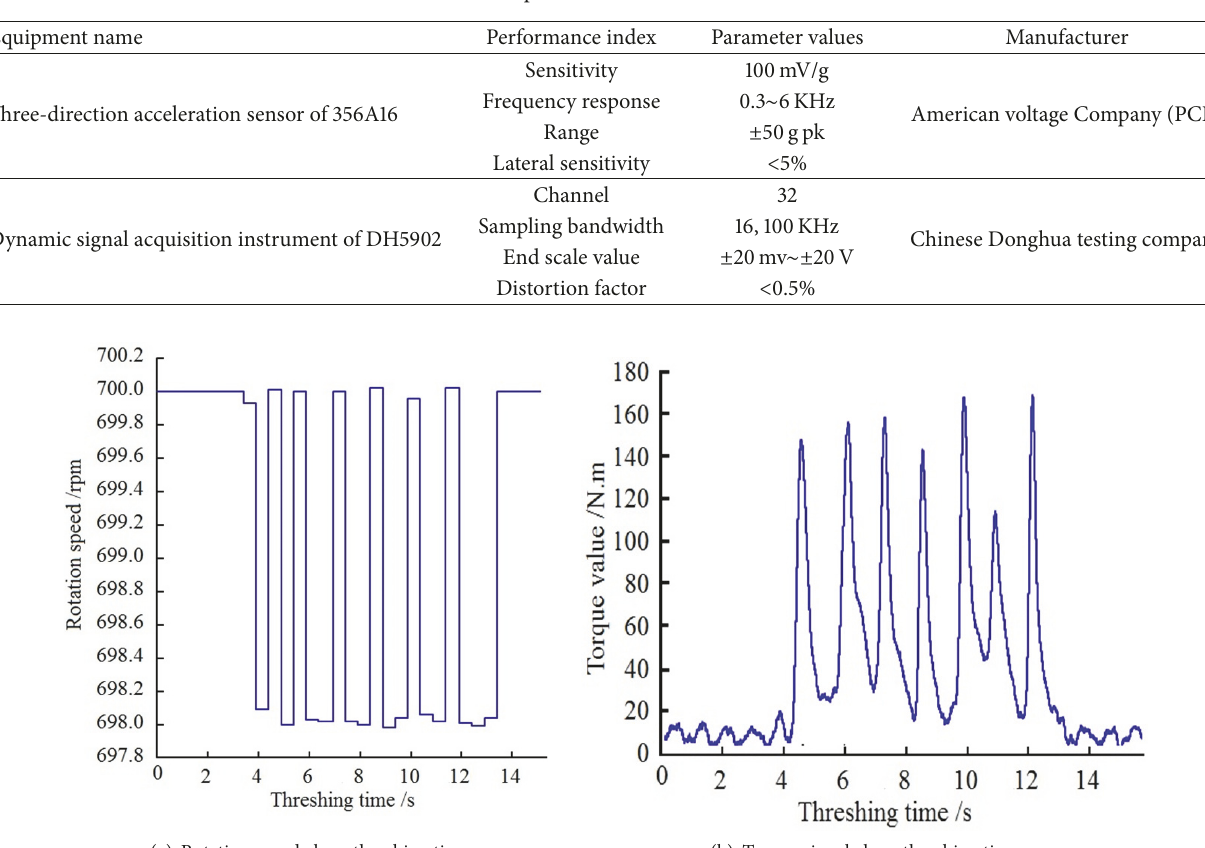
Table 1: Performance parameters of vibration test instruments.